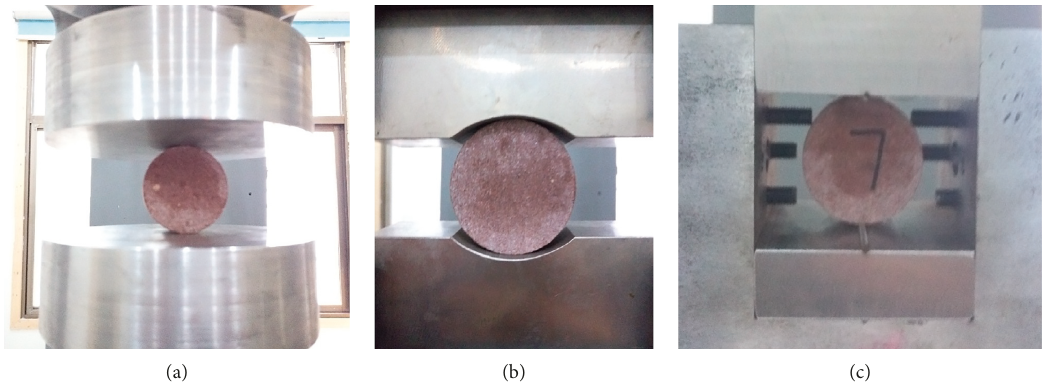
Figure 4: Three typical loading devices of the Brazilian disc test installed in the MTS-Landmark testing system. (a) The plate loading device. (b) The circular arc loading device. (c) The strip loading device.